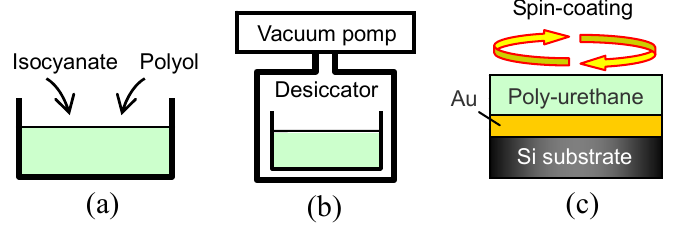
Figure 3. Fabrication process of polyurethane thin film. ( a ) Mixture of raw materials; ( b ) Progress of poly-urethane reaction in vacuum; ( c ) Spin-coating of polyurethane film and bake on.